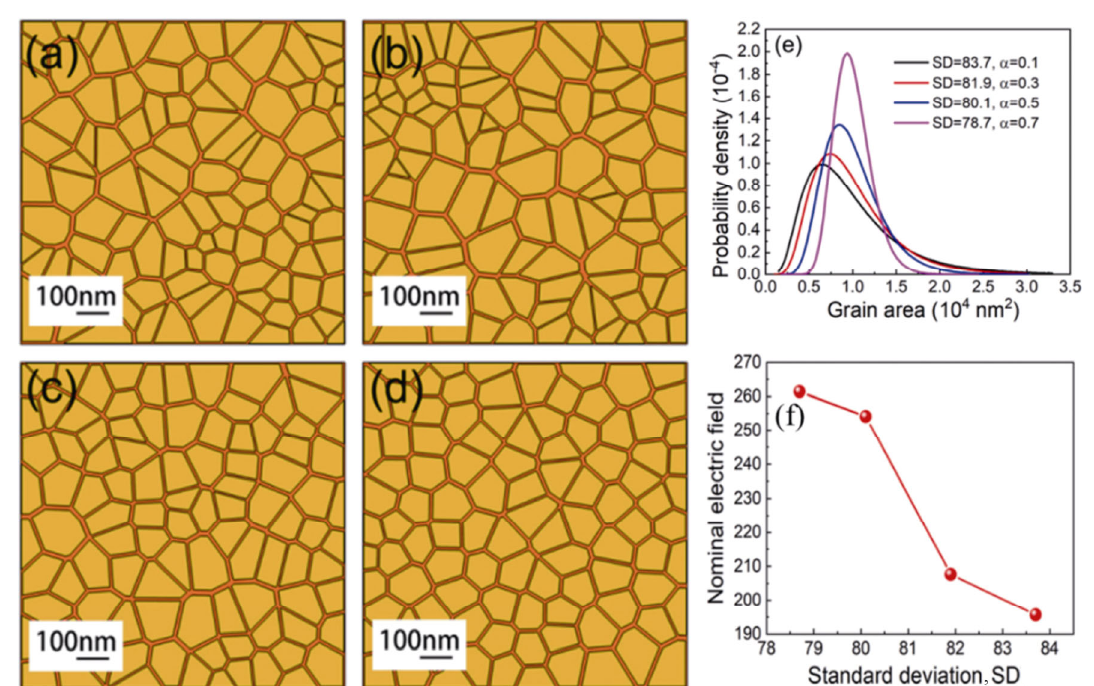
Fig. 19 Simulated samples generated with different α : (a) α = 0.1, (b) α = 0.3, (c) α = 0.5, and (d) α = 0.7. (e) Lognormal distribution fittings for the samples with various α . (f) Nominal electric field as a function of the standard deviation. Reproduced with permission from Ref. [108], © Author(s)